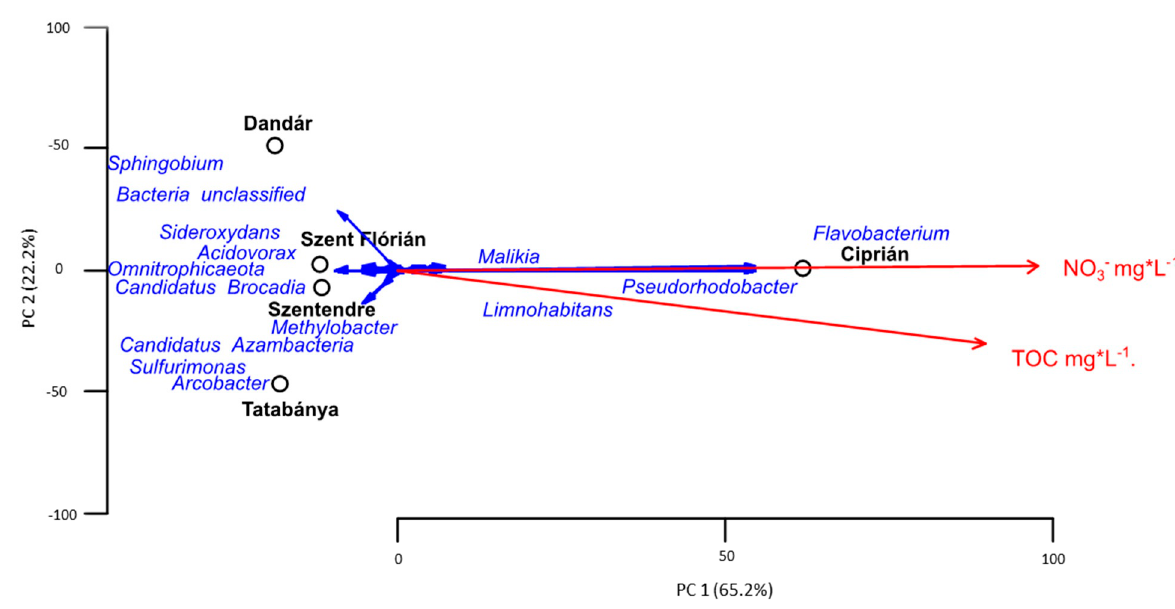
Figure 8. PCA ordination of the water samples based on bacterial community structure and environmental parameters.